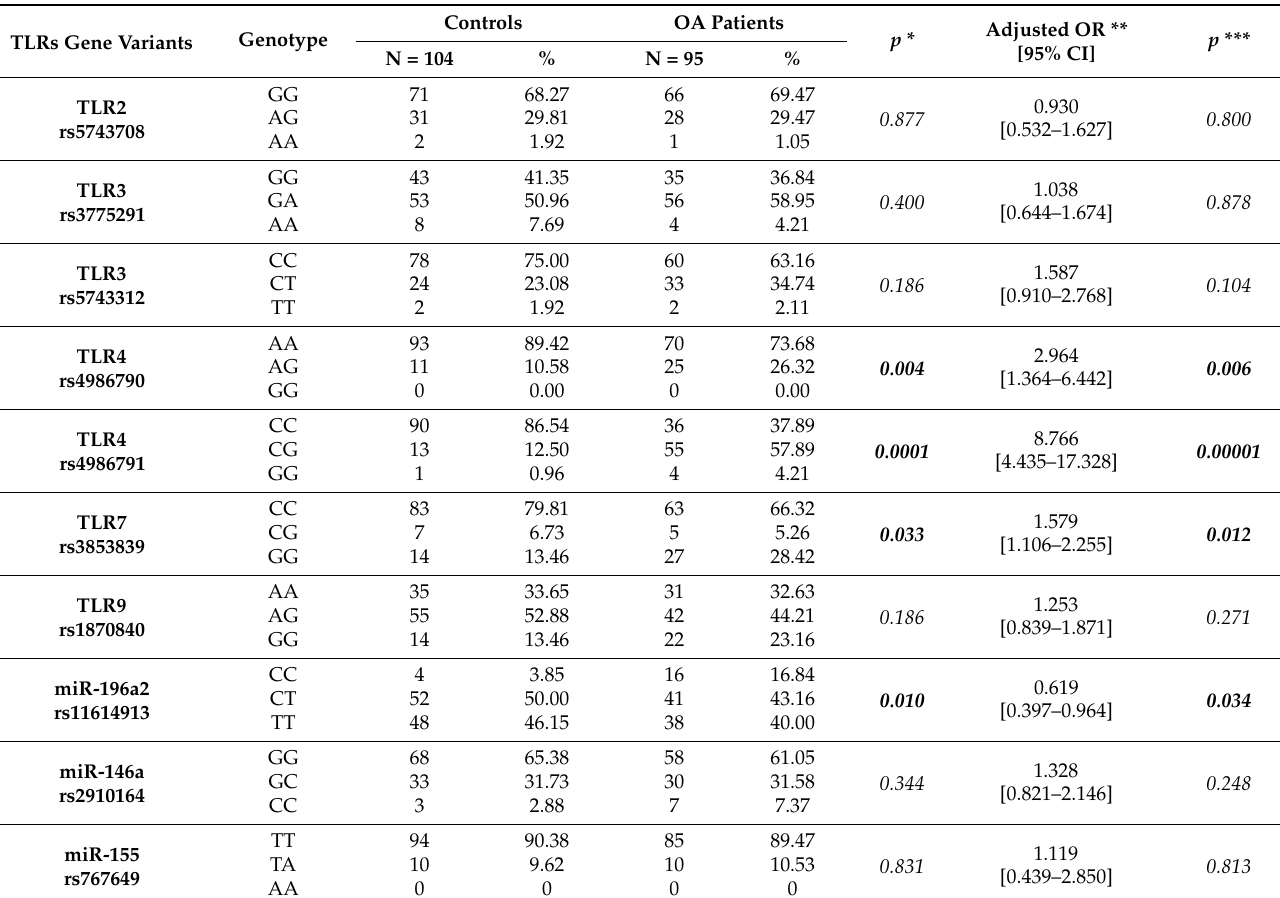
Table 4. Genotype frequencies and logistic regression analysis data for the TLR and miRNA gene polymorphisms in